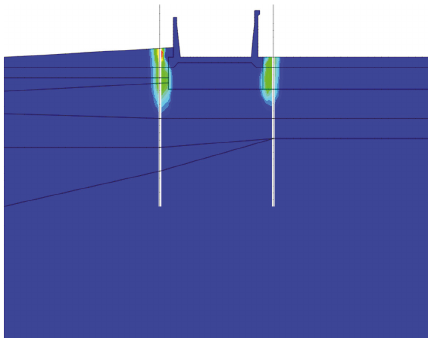
Figure 29: Maximum principal plastic strain of foundation soil- plane